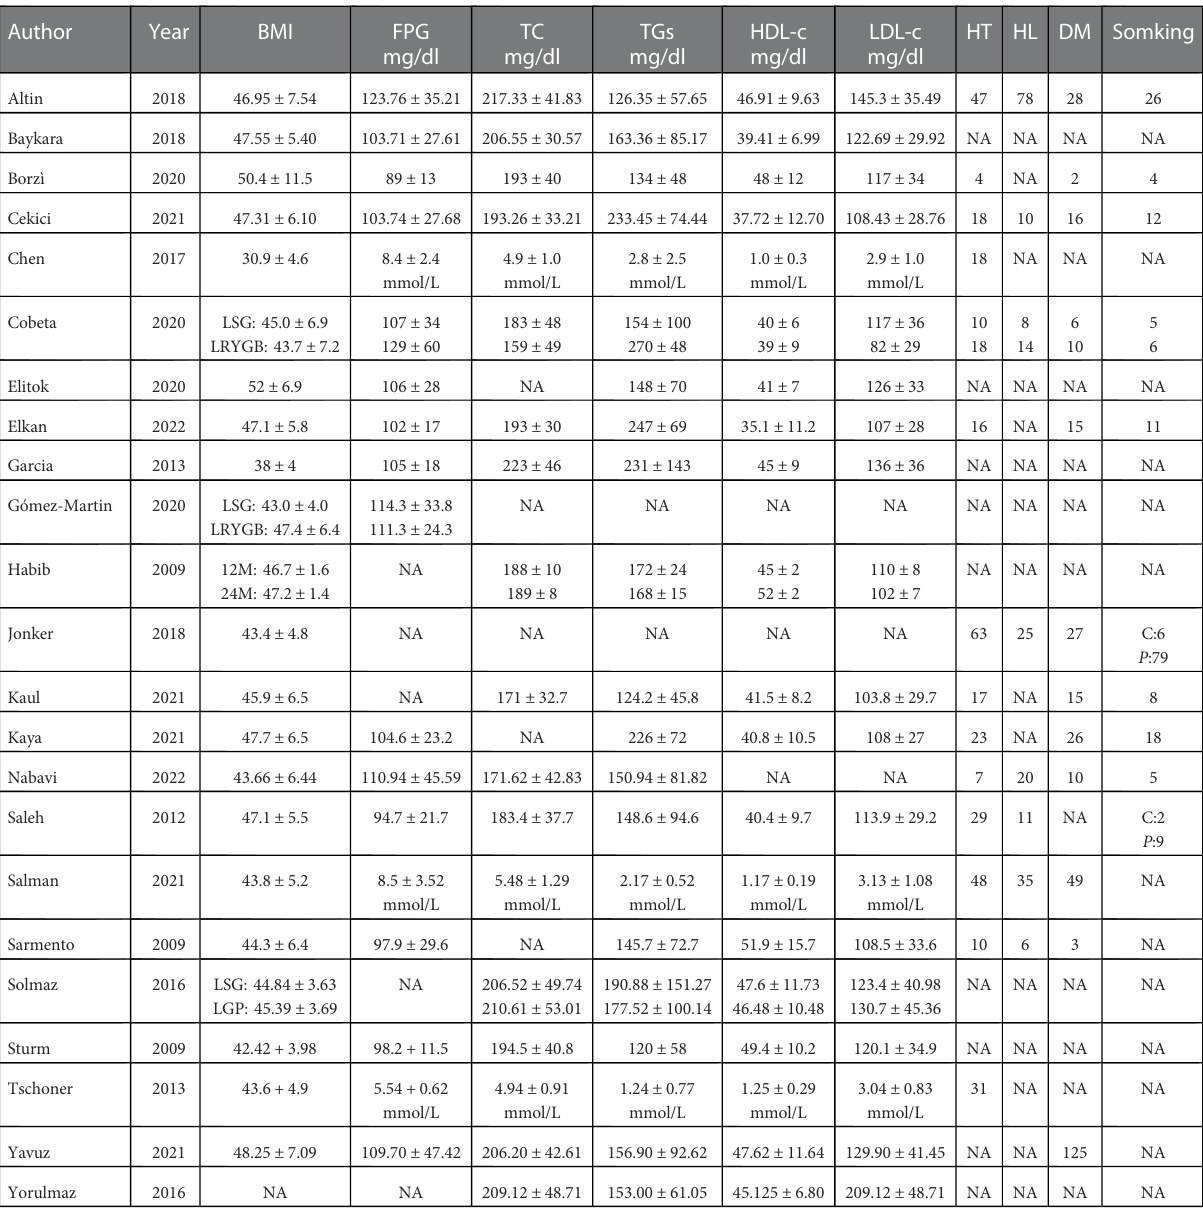
TABLE 2 Characteristics of the patients included in the study.